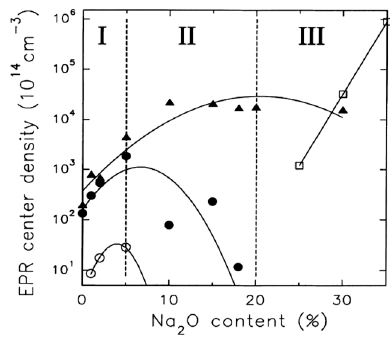
Figure 8. EPR center density in Na 2 O-GeO 2 glasses as a function of the Na 2 O content. The hollow circles refer to Ge-E’ signals before X-ray irradiation, the filled circles refer to Ge-E’ signals after X-ray irradiation, the filled triangles refer to Ge-NBOHC signals after X-ray irradiation, and the hollow squares refer to the g = 2.21 signal (unidentified). The lines are drawn as a guide for the eye. Reproduced from [77]. Copyrights Elsevier 2000.